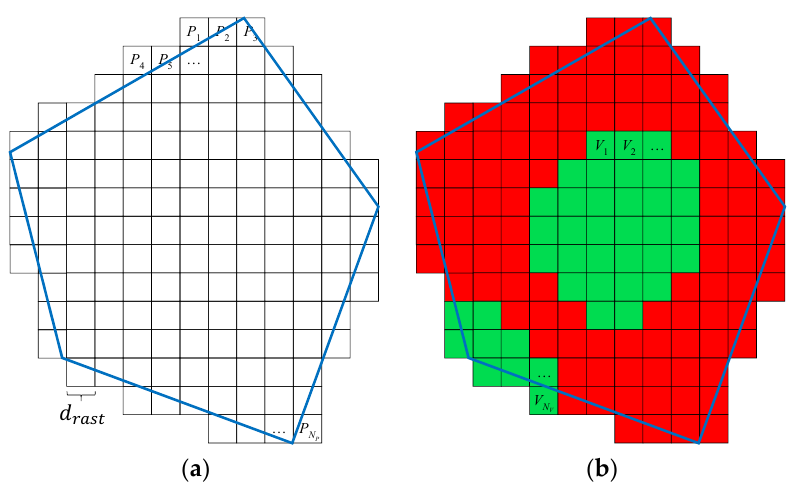
Figure 5. Rasterization of the area of interest: ( a ) points in the area of interest; ( b ) visible points.